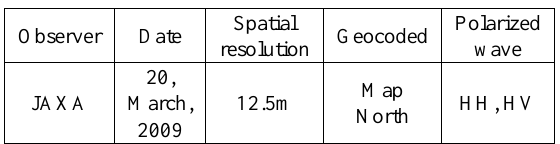
Table 3. Threshold values